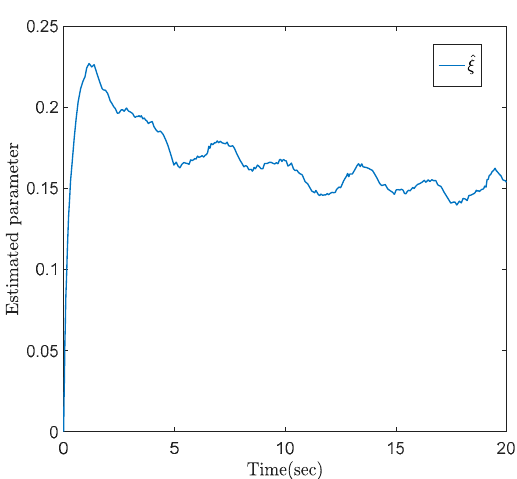
Figure 2. Tracking error y − y d .